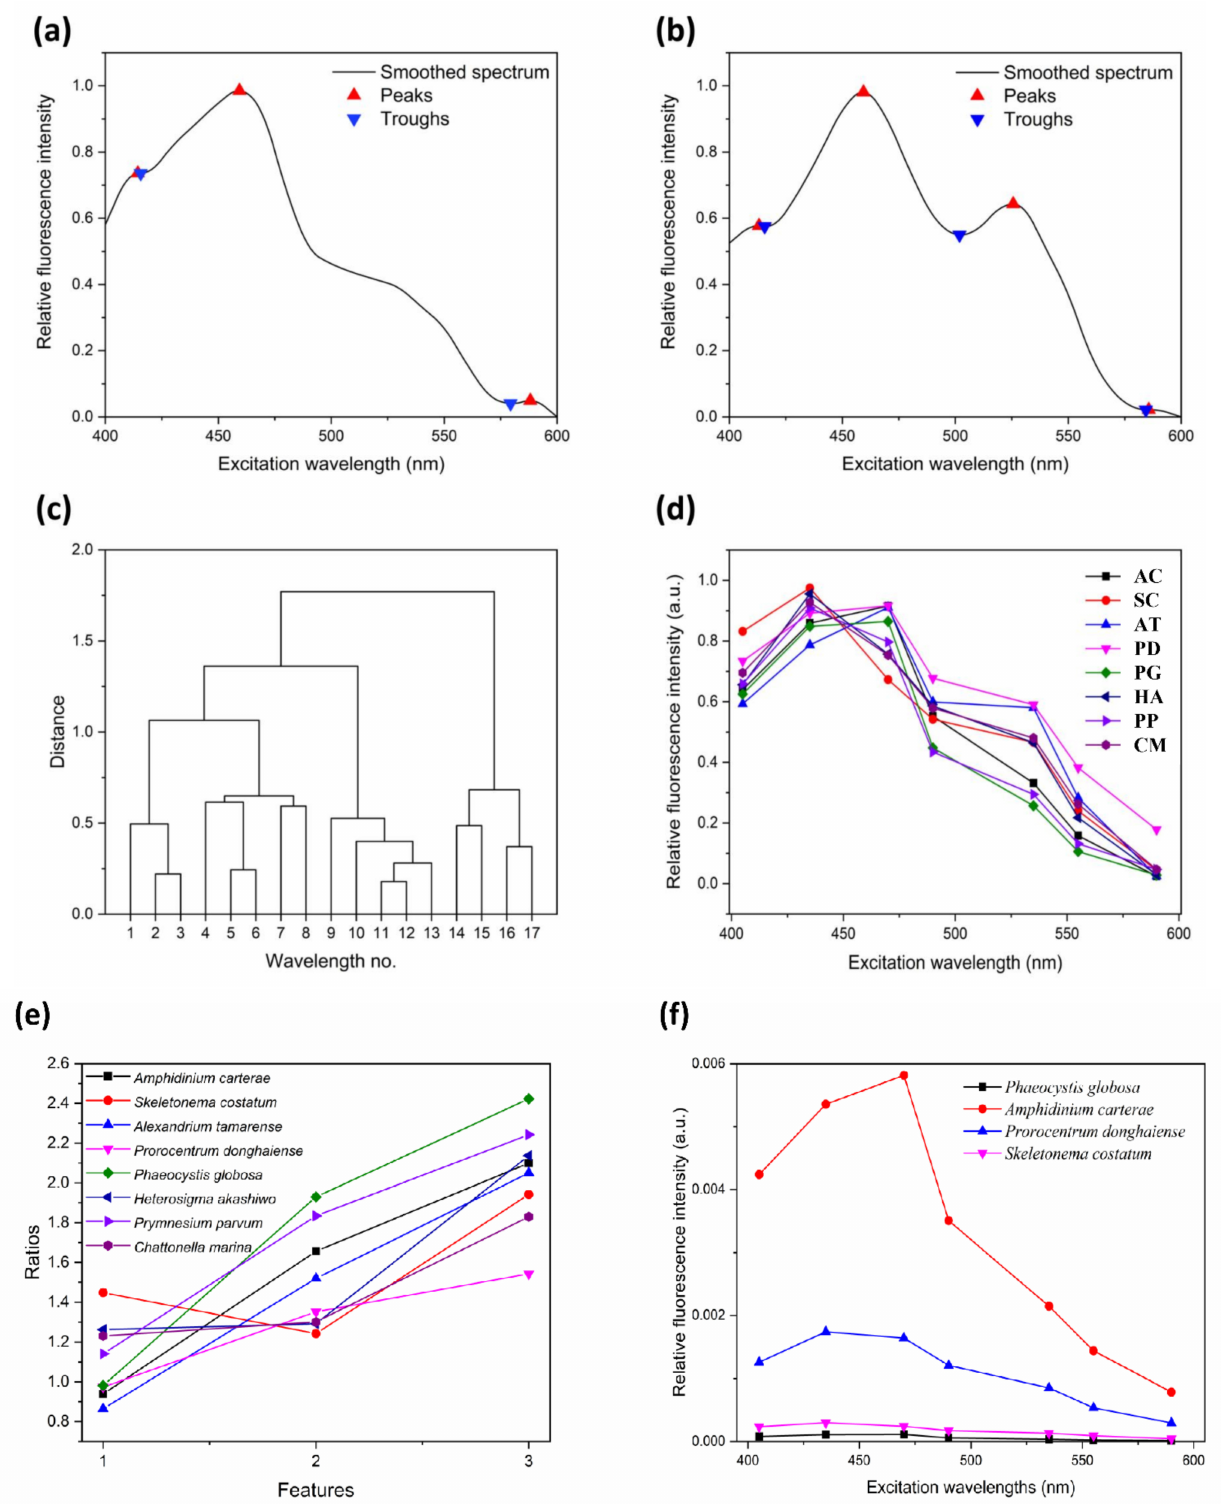
Figure 4. Process of feature extraction. ( a , b ) Peaks and troughs of smoothed excitation fluorescence spectra of AC and AT; ( c ) Hierarchical clustering graph of 17 wavelengths; ( d ) Feature spectra of eight species of algae at seven wavelengths; ( e ) Three ratios of relative fluorescence intensity between 435 and 470 nm, 470 and 490 nm, as well as 535 and 555 nm; ( f ) Norm spectra of AC, PG, SC, and